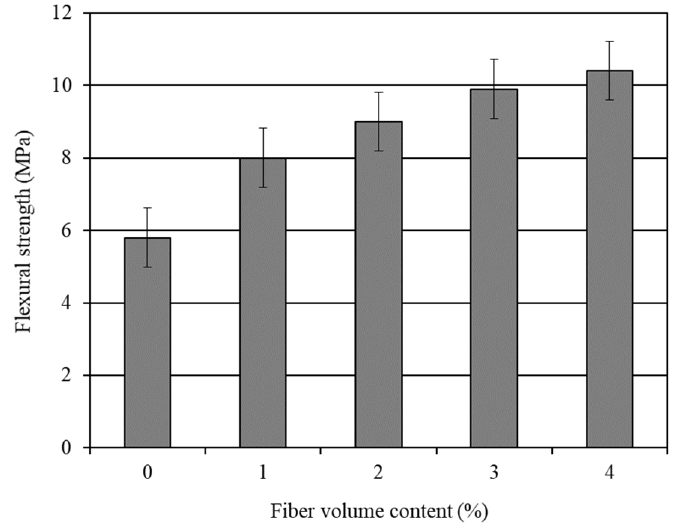
Figure 2. Influence of carbon fibers on the 28-day flexural strength of mortar composite.